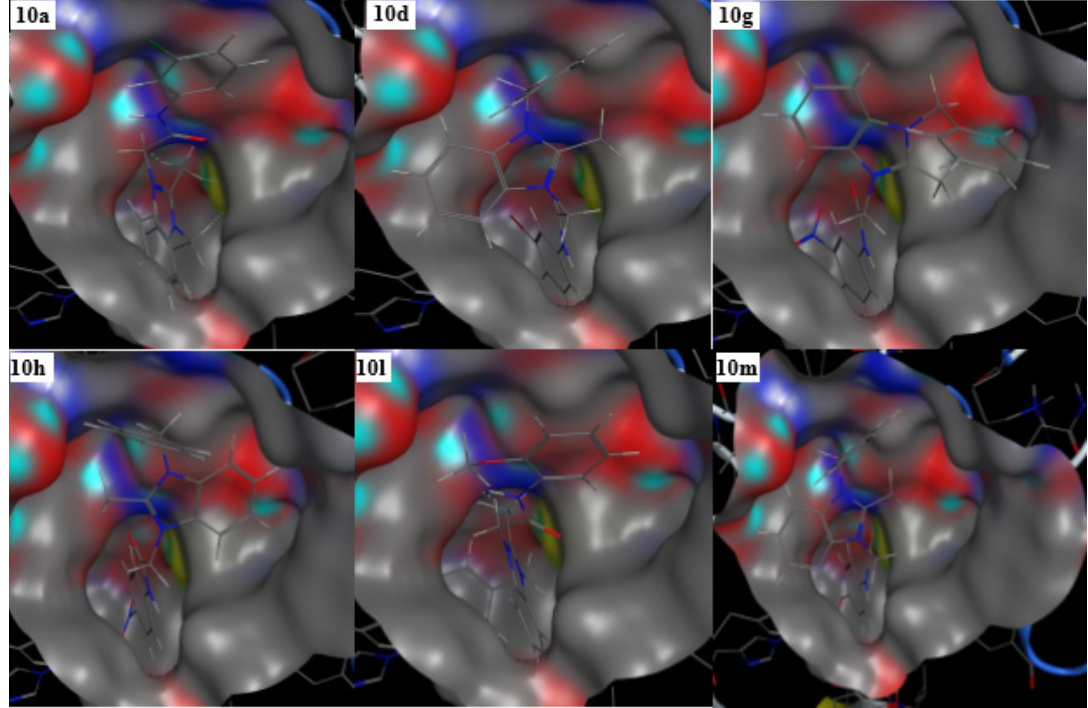
Figure 3. 3D interaction modes of active compounds ( 10a , 10d , 10g , 10h , 10l , and 10m ). Color portion shows the pocket. Selected and red portions indicate the ligand exposure points.